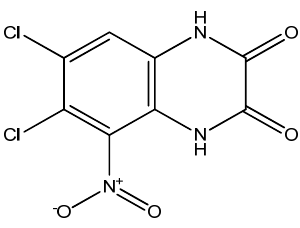
Figure 15. ACEA 1021.